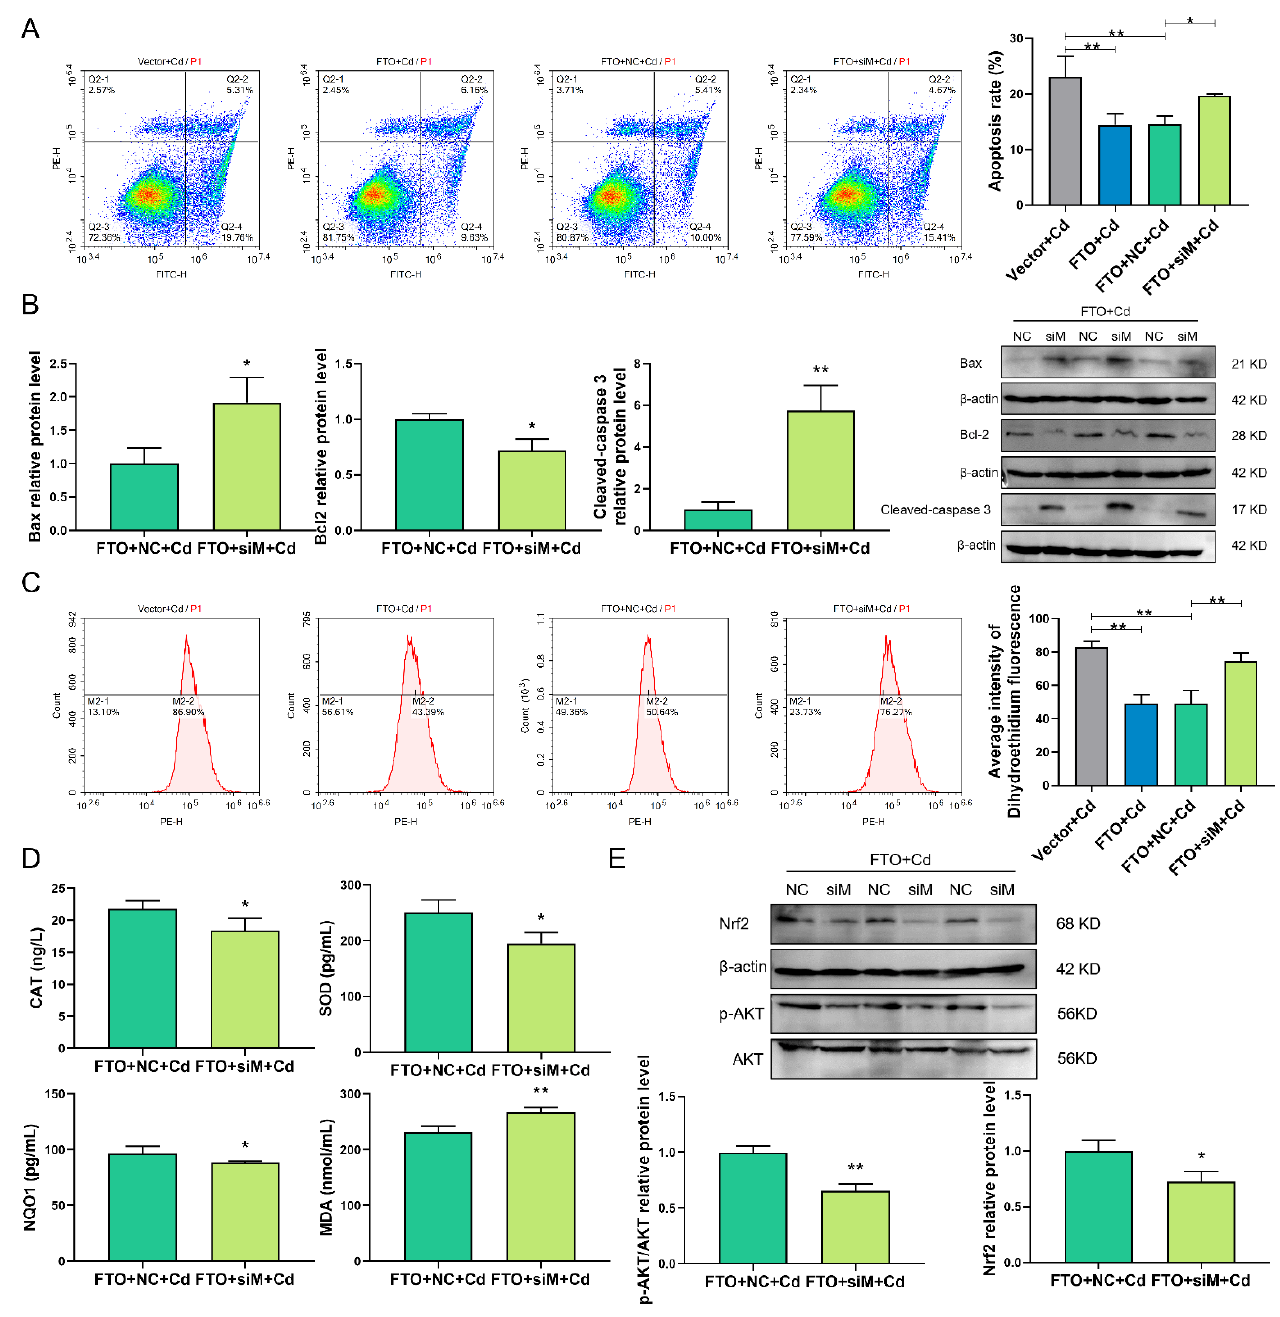
Figure 8. siMNT reverses the protective effect of FTO during Cd injury in granulosa cells. ( A ) Determination of the degree of apoptosis in the Vector + Cd, FTO + Cd, FTO + NC + Cd, and FTO + siM + Cd groups using flow cytometry analysis. ( B ) Western blotting results showed the protein expression levels of Bax, Bcl-2, and cleaved caspase-3 after siMNT and FTO treatments under Cd injury. ( C ) Intracellular level of ROS was measured using flow cytometry analysis (DHE) in Vector + Cd, FTO + Cd, FTO + NC + Cd, and FTO + siM + Cd groups. ( D ) ELISA results show the intracellular levels of CAT, SOD, NQO1, and MDA. ( E ) Nrf2 and AKT protein levels were analyzed by Western blotting after siMNT and FTO treatments under Cd injury. * p < 0.05; ** p <